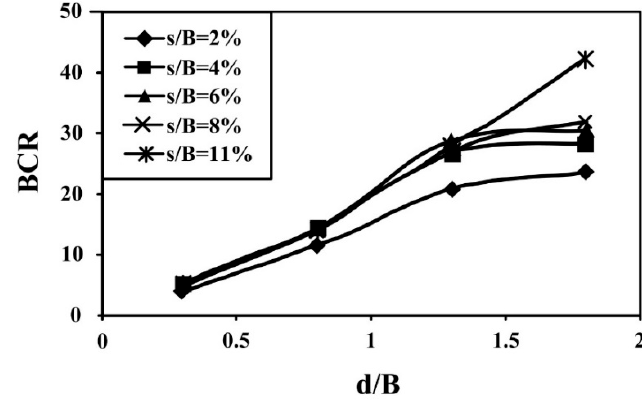
Figure 13. BCR variation against d / B ratios (modified from Sridhar and Prathapkumar [37]).